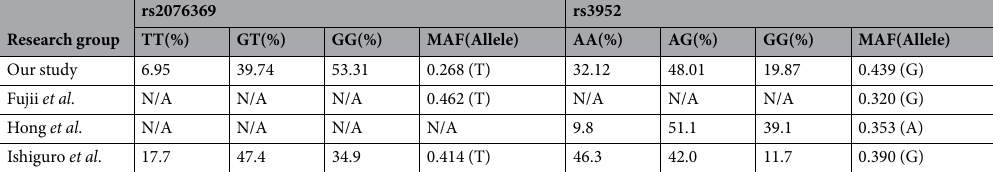
Table 3. PICK1 allele distribution in chronic schizophrenic patients of our study (n = 302), Fujii et al . 5 (n = 200), Hong et al . 17 (n = 225), and Ishiguro et al . 18 (n = 1851). MAF = Minor allele frequency, N/A = no data